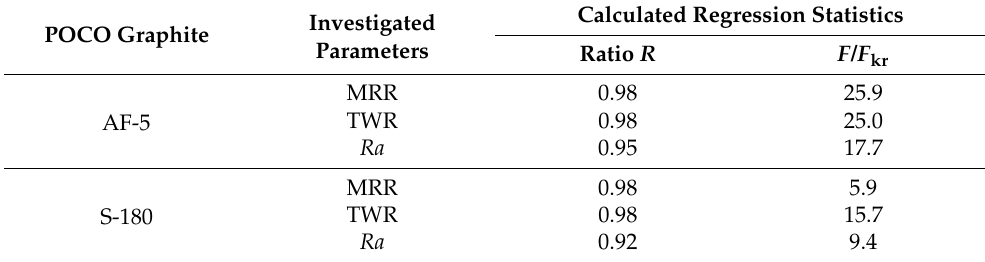
Table 6. Regression